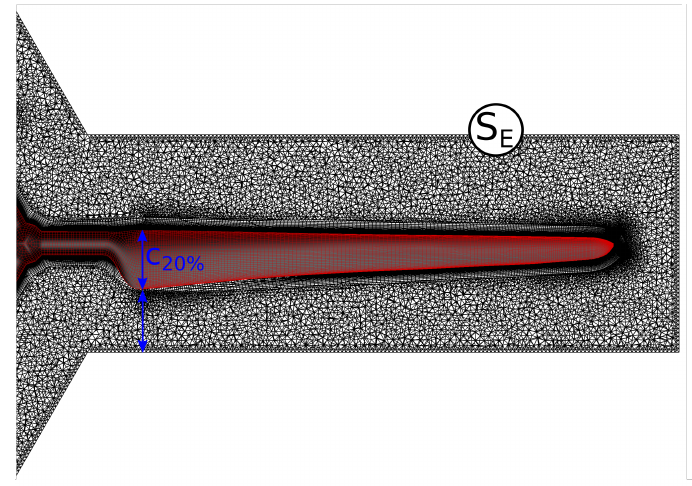
Figure 6. Eulerian sub-domain used in hybrid solver simulations.